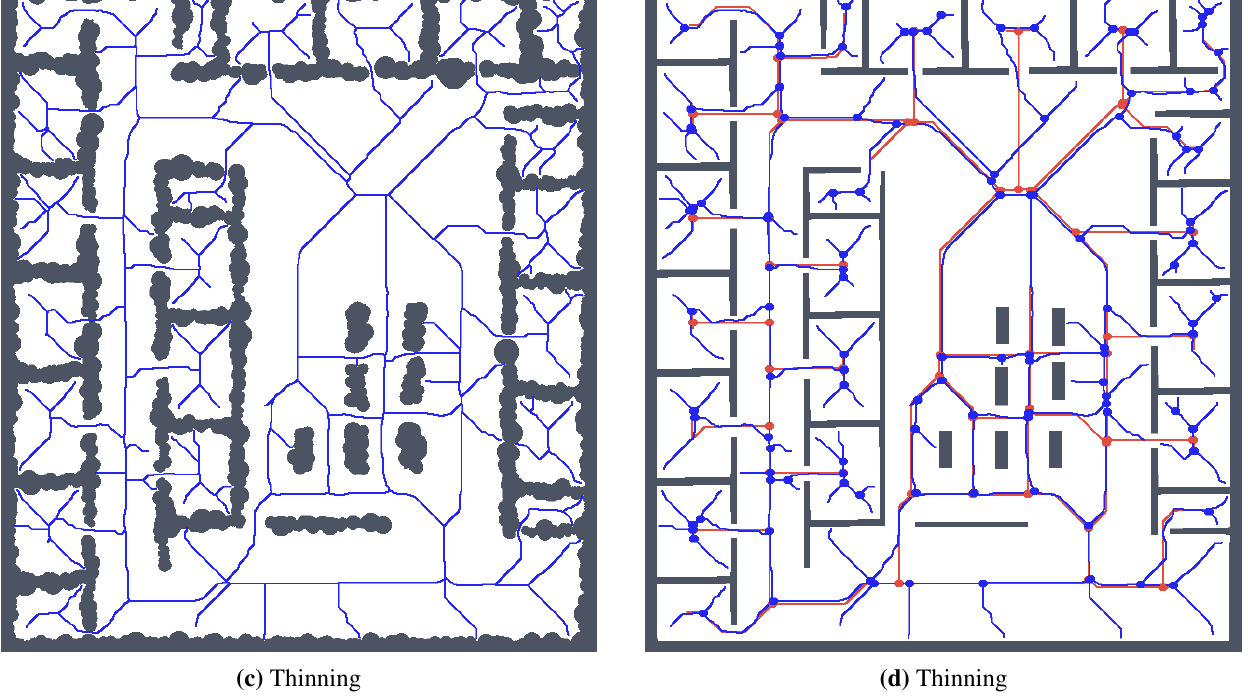
Figure 14. Determined skeletons and topological maps with highlighted junction places and leaves in the map jh with the noise level σ = 4 : ( a ) RD-based Voronoi diagram; ( b ) and its corresponding skeleton superimposed on the skeleton determined in the noise-less map (in red); ( c ) Pruned GVG representing skeleton of the map determined by the thinning algorithm [12]; ( d ) and the corresponding skeleton superimposed on the skeleton determined in the noise-less